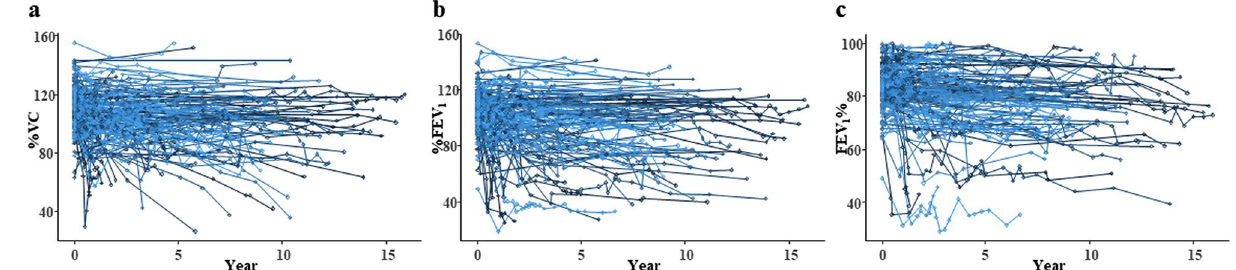
Figure 1. Transition of pulmonary function test values ( a ) percent vital capacity (%VC), ( b ) percent of predicted forced expiratory volume in one second (%FEV 1 ), and ( c ) FEV 1 /forced VC ratio (FEV 1 %).